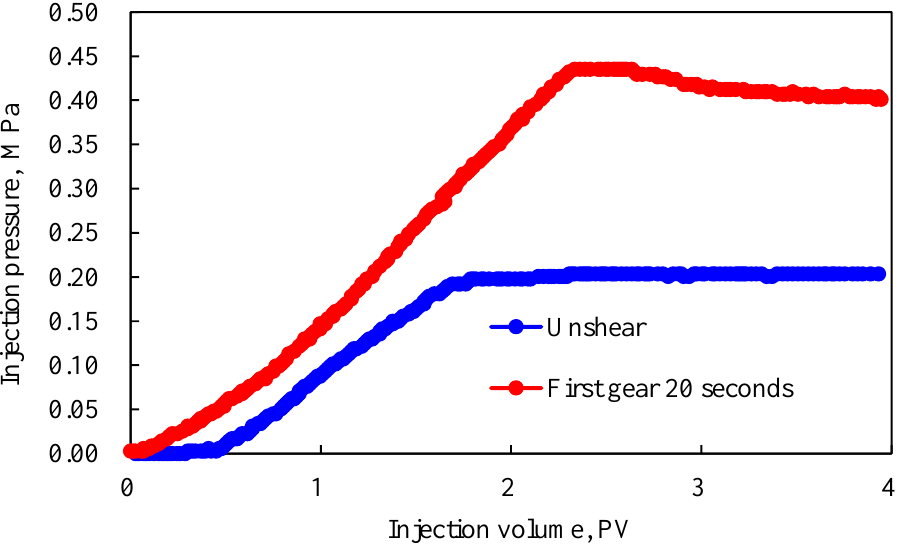
Figure 7. Effect of shear on the percolation characteristics of the polymer solution.